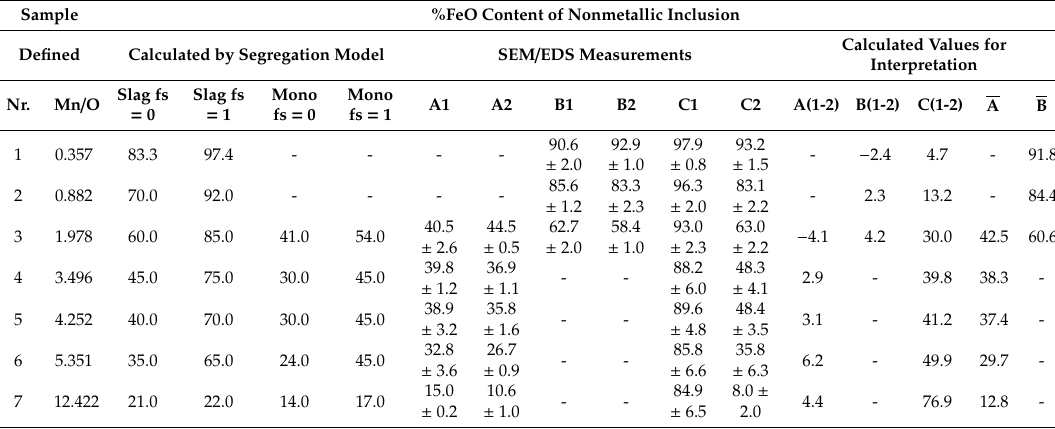
Table 4. Calculated and measured wt